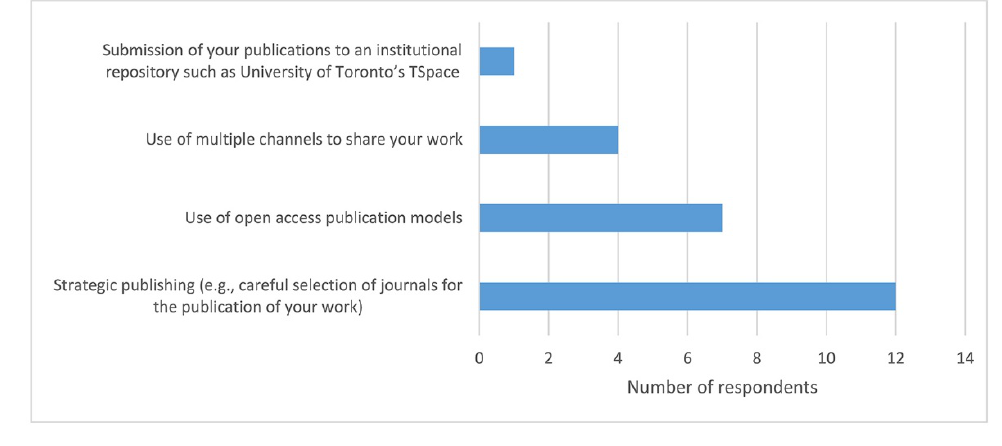
Figure 4 Strategies for maximizing research impact